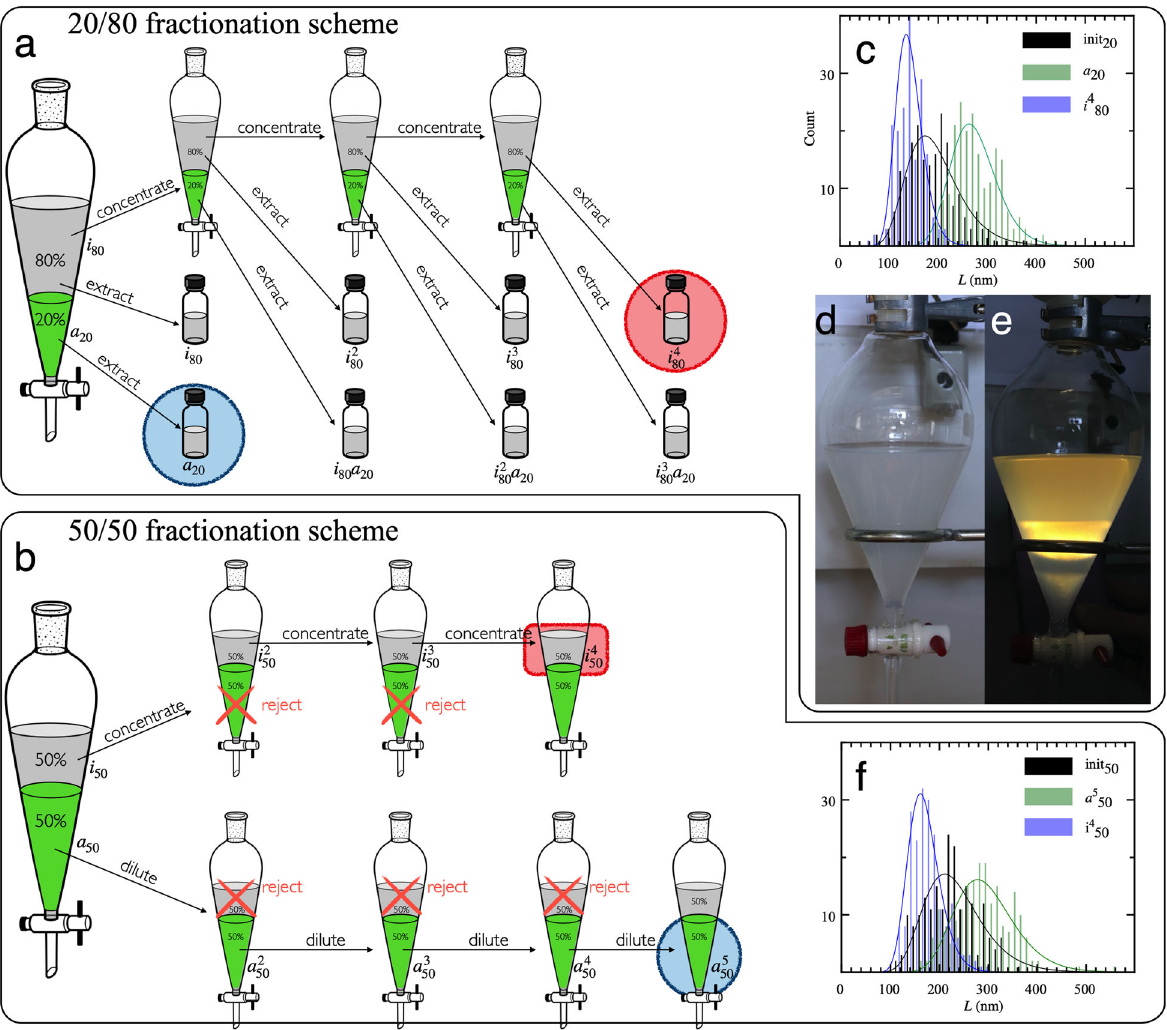
Fig. 1 Fractionation of CNCs by liquid crystal formation. The different steps in the two schemes, as well as the labelling of each fraction, are summarised for 20/80 separation in ( a ) and 50/50 separation in ( b ). For each scheme, the longest CNC fraction is highlighted with blue background and the shortest CNC fraction with red background. Excerpts (initial suspension and the two extreme fractions from each scheme) of the resulting distributions of CNC lengths L are shown in ( c ) and ( f ). Bars are raw data from AFM analysis, curves are log-normal fi ts to experimental data. All data are summarised in Table 1 and Supplementary Fig. 5, and the analysis procedure is described in Supplementary Note 2. The boundary between isotropic and cholesteric phases is dif fi cult to see with ambient light ( d ) but it is revealed by illumination from behind (